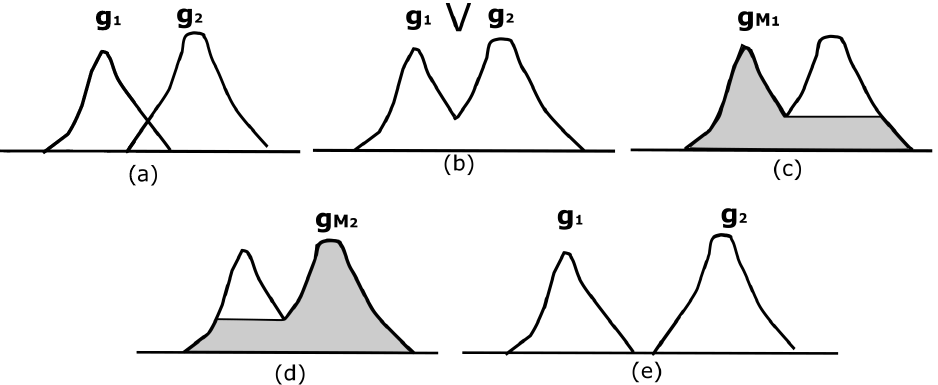
Figure 5. Hyperconnected functions. ( a ) Two functions g 1 and g 2 ; ( b ) supremum of the functions in ( a ); ( c , d ) display two hyperconnected functions with a maximum; ( e ) trivial hyperconnected functions g 1 and g 2